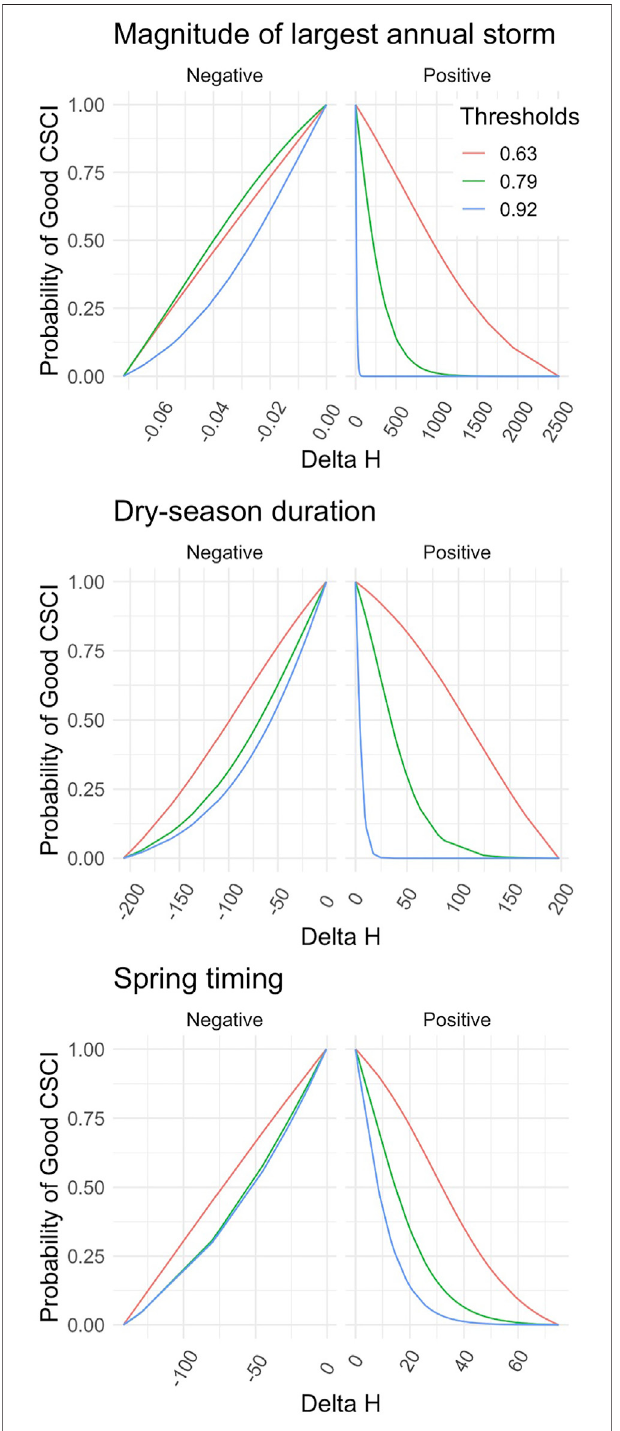
FIGURE5| Flow-Ecologyrelationshipbetweenprobabilityofachievinga healthyASCIscoreandallchosenFFM.Each threshold referstothe fi rst,10th and 30th score percentile, i.e., likely altered, possibly altered and likely intact.